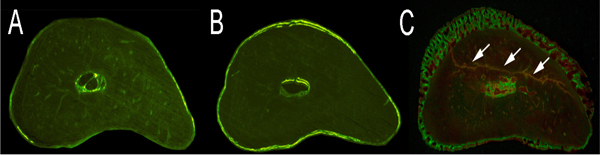
Cellular changes of bone tissues under control, normal loading, and fatigue loading conditions. A: Control condition (no loading); B: Normal loading condition. The thick staining at the perimeter of bone tissues indicates bone formation; C: Fatigue loading condition. The microdamage (indicated by arrows) and bone formation at the peripherals of bone tissues are clearly visible.